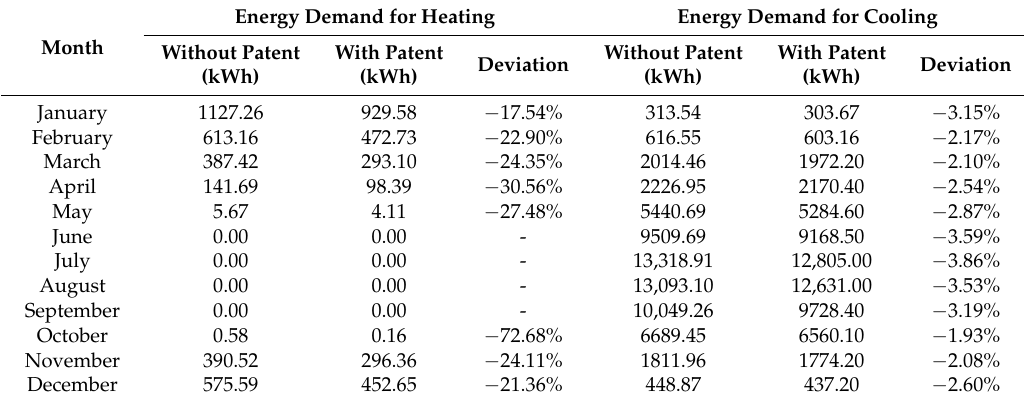
Table 8. Differential of energy demand between the case study without patent and the one with patent for the period of